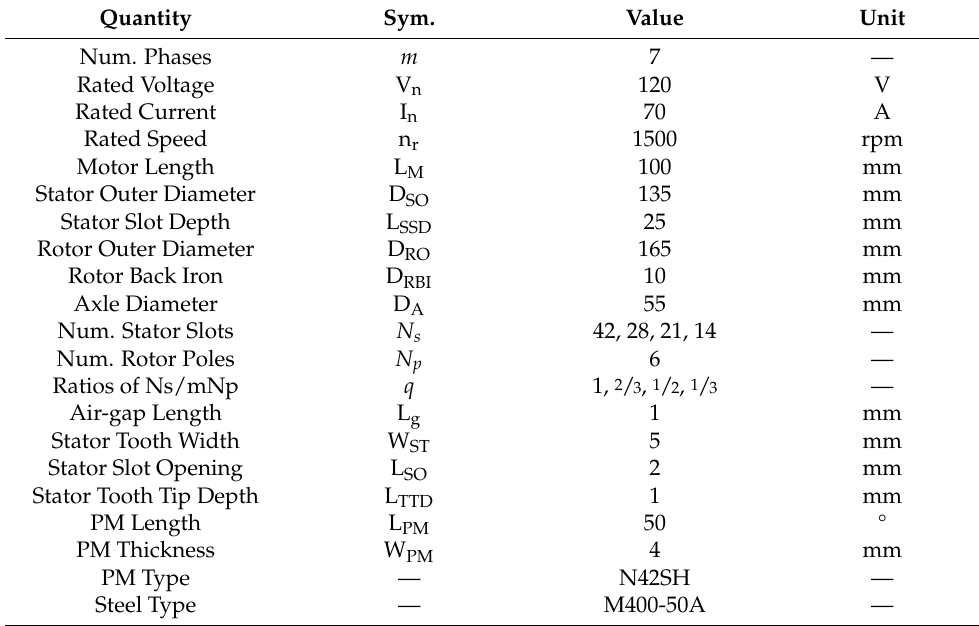
Table 2. Initial Design Parameters.